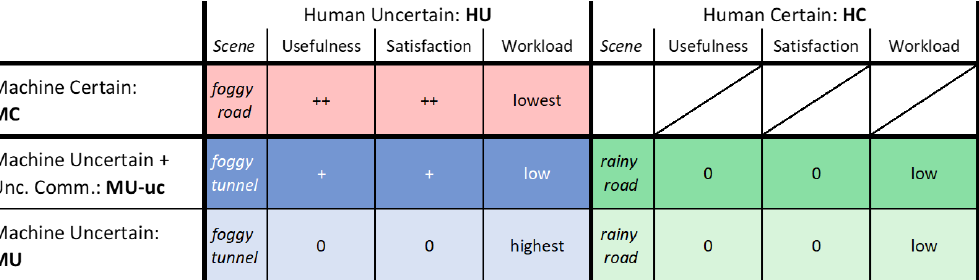
Figure 7. Predicted outcome of subjective evaluations according to our research hypotheses when assuming successful experimental manipulations. Usefulness and satisfaction: Symbols +,0 are used to illustrate the predicted valuation. Relative workload predictions were given verbally. For machine uncertain conditions (blue and green), the light colors mark conditions without uncertainty communication. Their dark counterparts indicate uncertainty